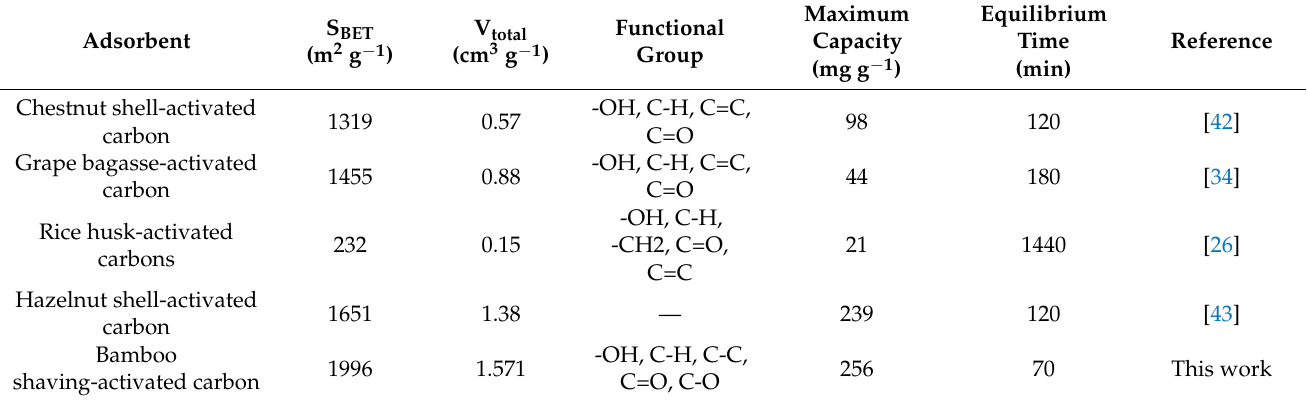
Table 4. Comparison of maximum adsorption properties of different adsorbents for Cu(II).